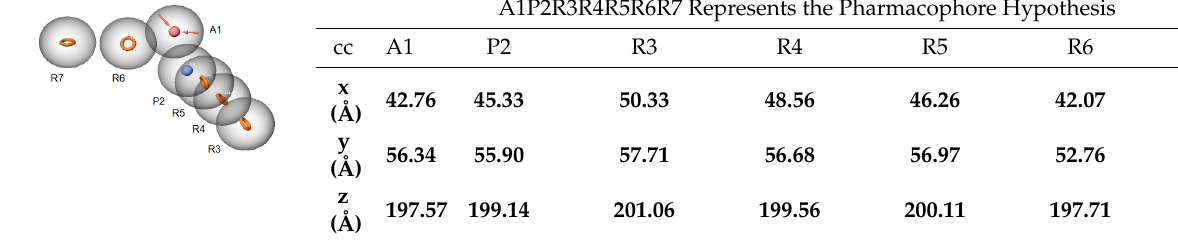
Table 1. Pharmacophore hypothesis for salt 3j in complex with ATP synthase. Pink spheres represent acceptor atoms (A), and blue spheres represent positive ionic atoms (P), orange rings represent aromatic centers (R). CC cartesian coordinate (Å).